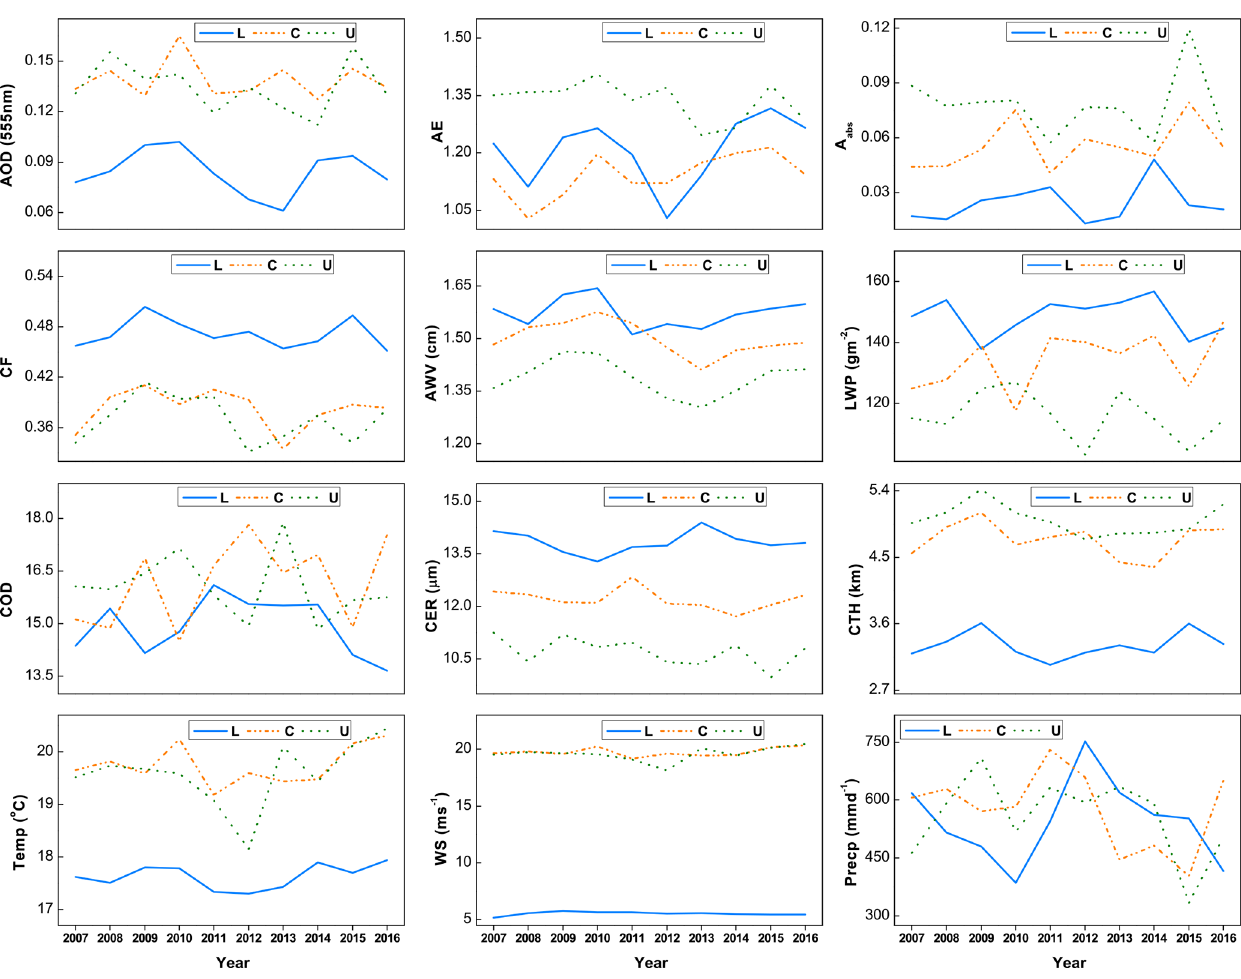
Figure 14. Interannual variation of monthly means for aerosol (AOD, AE, A abs ), AWV, cloud (CF, LWP, COD, CTH, CER), and meteorology (WS, TEMP, PRECP) parameters over upper (U; dotted green line), central (C; dotted orange line) and lower (L; solid blue line) South